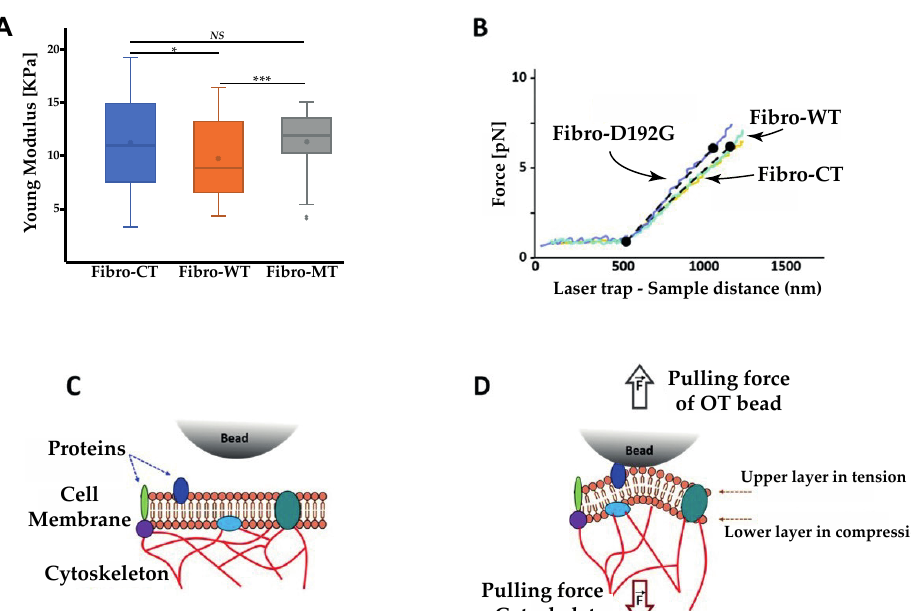
Figure 7. Nanotube extrusion measured using the optical tweezers. ( A ) Nanotube stiffness (expresses as Young’s modulus) between different conditions NRVFs. (n Fibro-CT = 60, n Fibro-WT = 58, n Fibro-MT = 70, analyzed curves, respectively). ( B ) Force curve between NRVFs CT, WT, and NRVFs with LMNA D192G mutation. ( C ) Cartoon showing the resistance force impacting the nanotube extrusion. ( D ) The pulling force of the OT bead after the interaction with the plasma membrane is counteracted by bending rigidity (with stretching and compression of membrane layer) and surface tension (with pulling force of cytoskeleton), (*** p < 0.0001; * p < 0.05; NS = non-significant).